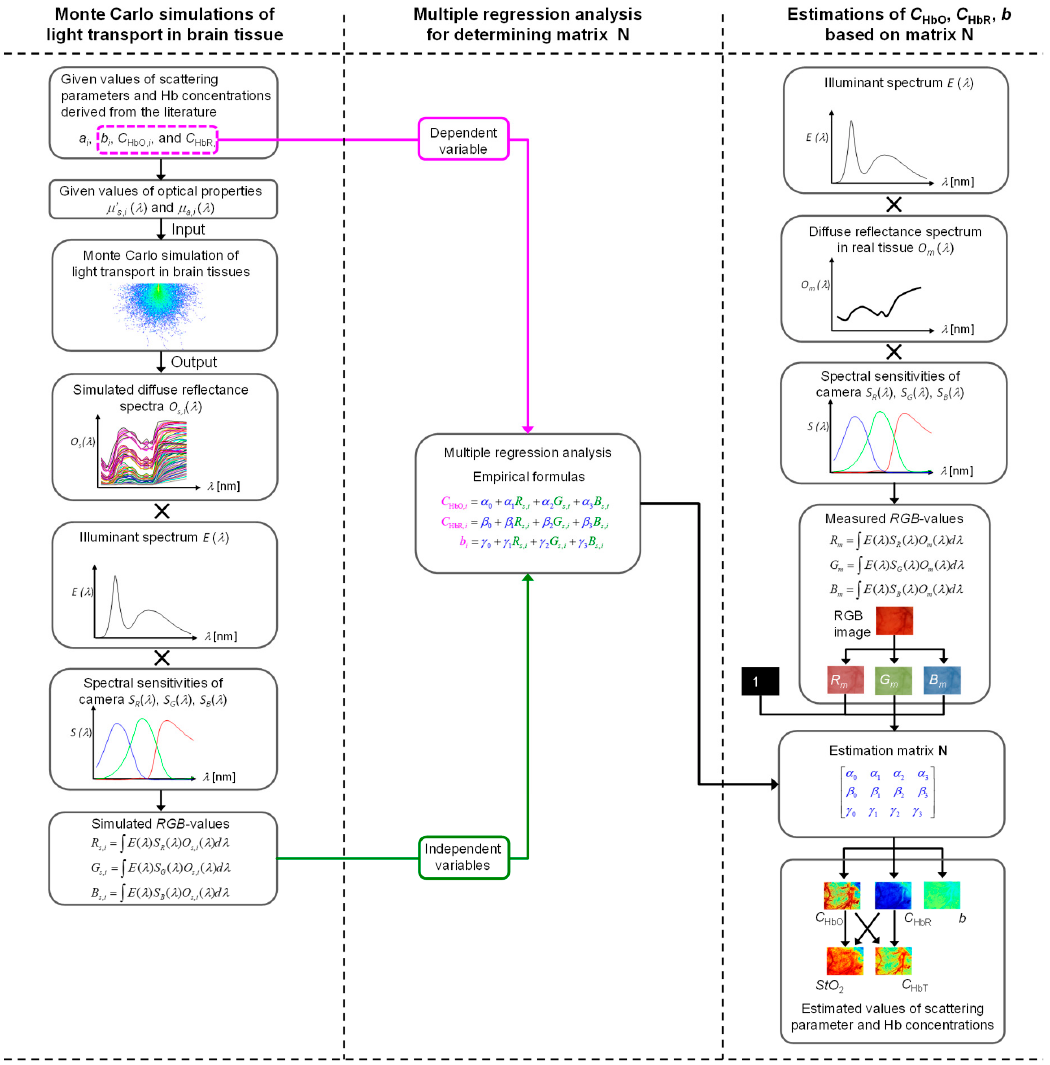
Figure 6. Flow diagram of the process for estimating the concentration of oxygenated hemoglobin C HbO , the concentration of deoxygenated hemoglobin C HbR , the concentration of total hemoglobin C HbT , hemoglobin oxygen saturation StO 2 , and scattering power b .